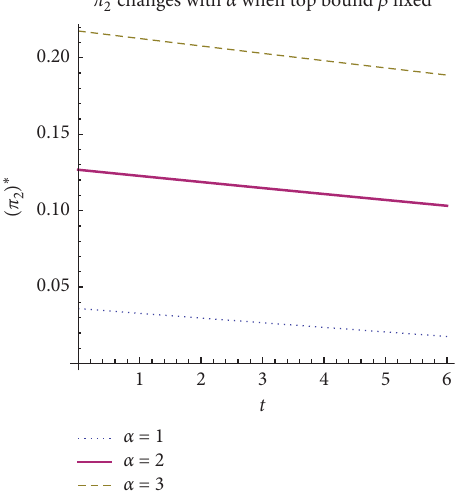
Figure 2: Values of π ∗ change with t for different bottom bound α 2